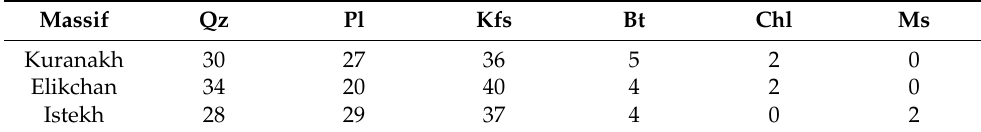
Table 2. Composition of granites (in vol